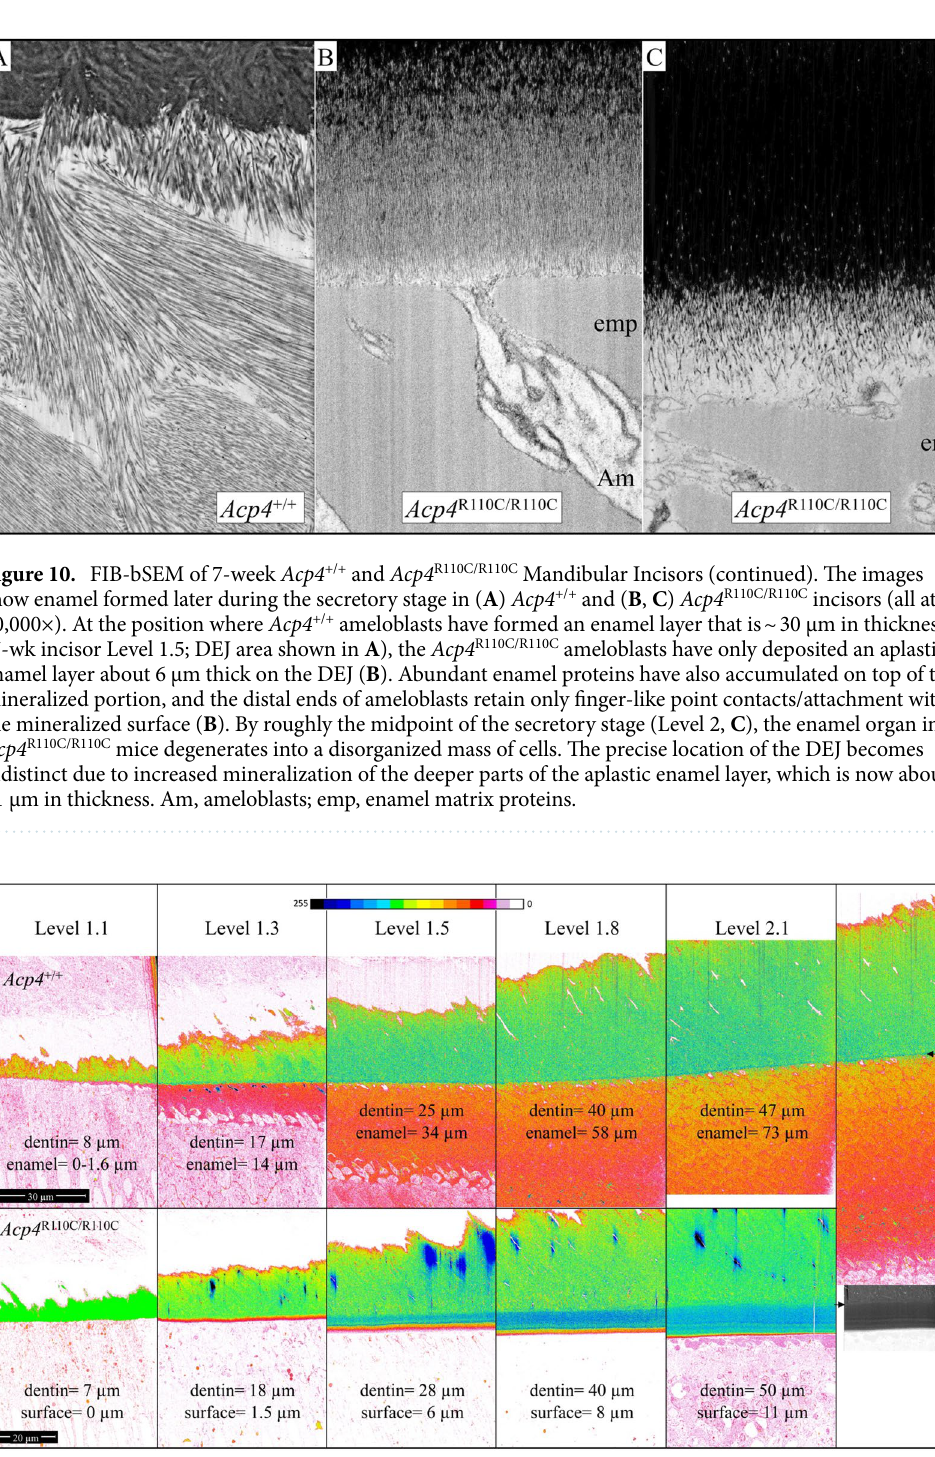
Figure 11. Pseudocolored FIB-bSEM Images of the DEJ Region in Acp4 +/+ and Acp4 R110C/R110C Mandibular Incisors. Images of various sites along DEJ from Level 1.1 (start enamel formation) to Level 2.1 (mid secretory stage) are presented (all at 1500×). The image in the righthand panel shows the full thickness of dentin and enamel layers in Acp4 +/+ mice at Level 2.1. Beneath it is grey scale image illustrating the difficulty of trying to decide where the DEJ is located because of multiple variations in image intensity across the aplastic enamel layer. Measurements of dentin thickness in the pseudocolored images provides a direct method to delineate this boundary. These measurements provide evidence that dentin formation appears normal within the Acp4 R110C/ R110C mice and that loss of ACP4 function leads to production of little more than a dysfunctional initial enamel layer on the surfaces of mutant teeth. Inverted backscatter intensity pseudo color ramp is shown at the top of the